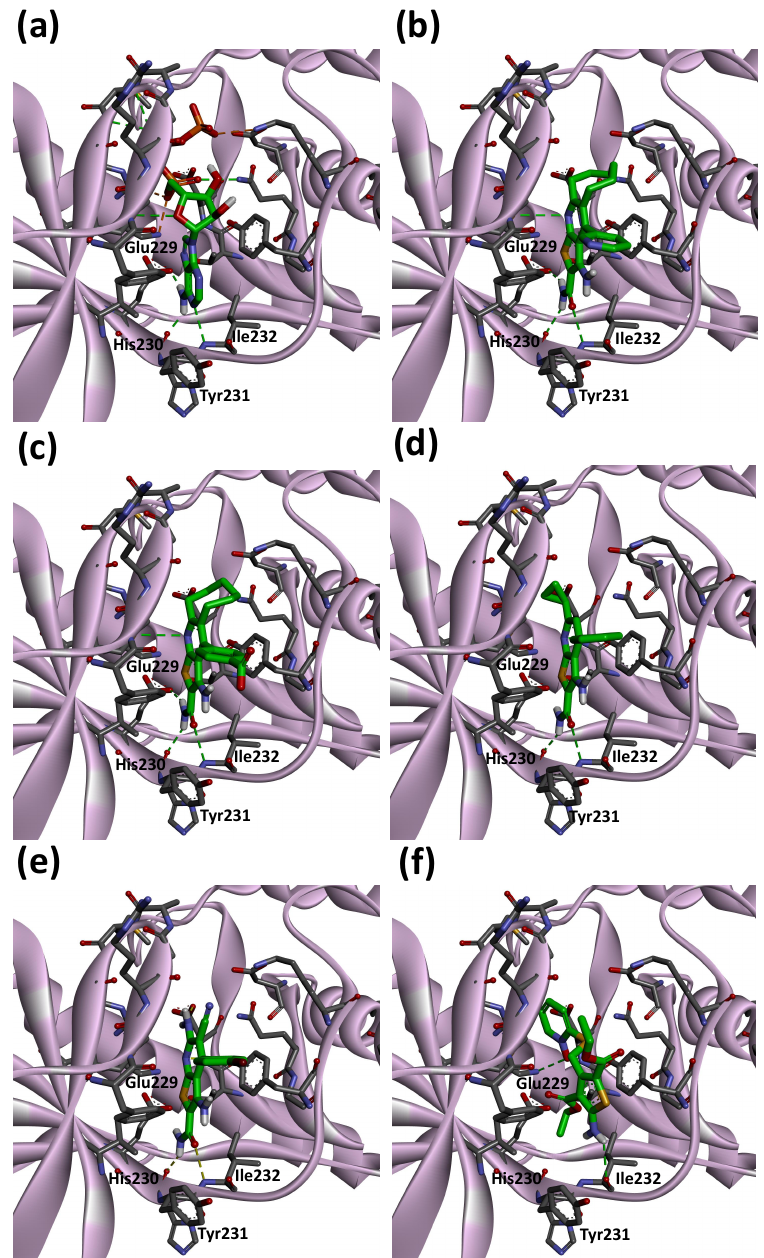
Figure 6. Predicted binding modes of ATP ( a ), CHEMBL1089330 ( b ), CHEMBL1090045 ( c ), compound 2 ( d ), compound 4 ( e ) and compound 13 ( f ) on eEF2K homology model. Carbon, nitrogen, oxygen and hydrogen are shown in green (ATP, compound 2, compound 4 and compound 13)/gray (eEF2K), blue, red and white, respectively. Dashed lines indicate hydrogen bond interactions. eEF2K is shown as ribbon